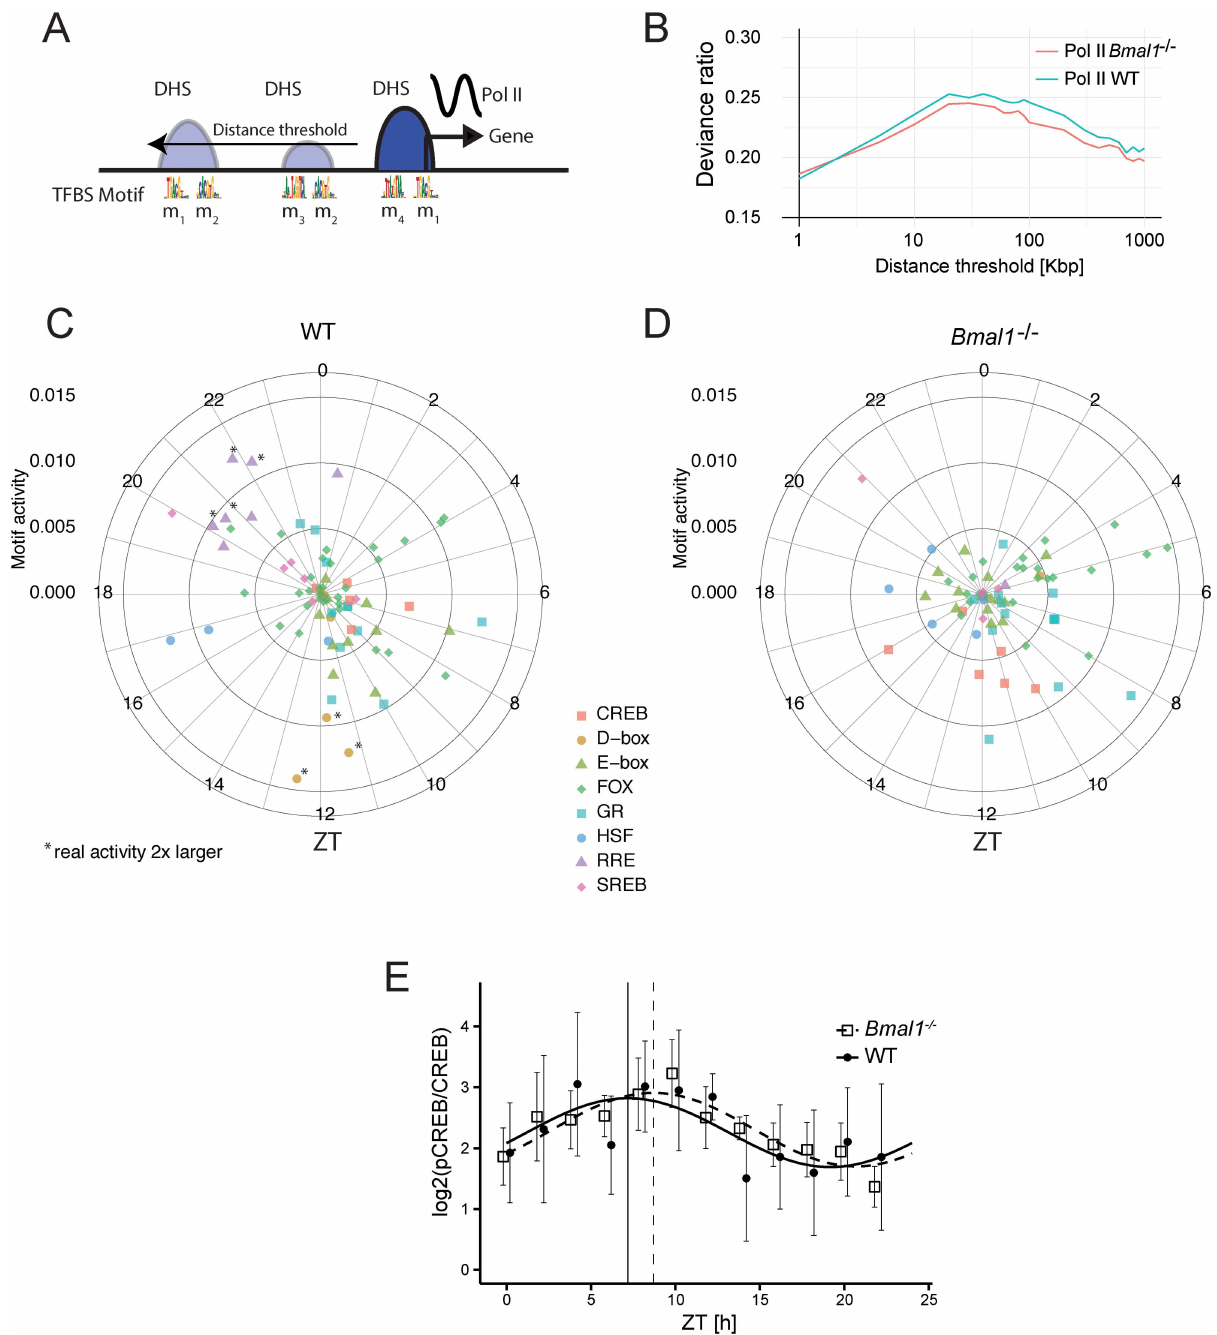
Fig 4. Distal DNaseI Hypersensitive Sites (DHSs) help identify diurnally active transcription regulators. A. Scheme of the linear model to infer active transcription regulators:transcription factor (TF) motifs in DHSs within a symmetric windowaroundactive transcription start sites (TSSs) are used to explaindiurnalrhythms in transcription. B. Fraction of explainedtemporalvariance (deviance ratio) in RNA polymerase II (Pol II) loading(at the TSS of all actives genes)for WT and Bmal1 -/- mice, in function of the windowsize (radius) for DHS inclusion,shows a maximum at around50 kb. Here, α = 0 was used in the glmnet (Materialsand methods). C–D. Inferred TF motif activities for WT and in Bmal1 -/- mice shown with amplitudes (distancefrom center) and peak times (clockwise, ZT0 at the top) using a windowsize of 50 kb. All 819 (WT) and 629 ( Bmal1 -/- ) motifs (overlapis 427) with nonzeroactivities are shown. Note though that most activities are very small and cluster in the center. Certainfamilies of TFs are indicatedin colors (full results are providedin S4 Table). Radialscale for activities is arbitrary but comparable in C and D. E. Quantification of western blots for pCREB (Ser 133 phosphorylation) and CREB in WT and Bmal1 - /- genotypes (log 2 (pCREB/CREB)). Nuclearextracts from four independent livers were harvestedevery 2 h. Both genotypesshoweda